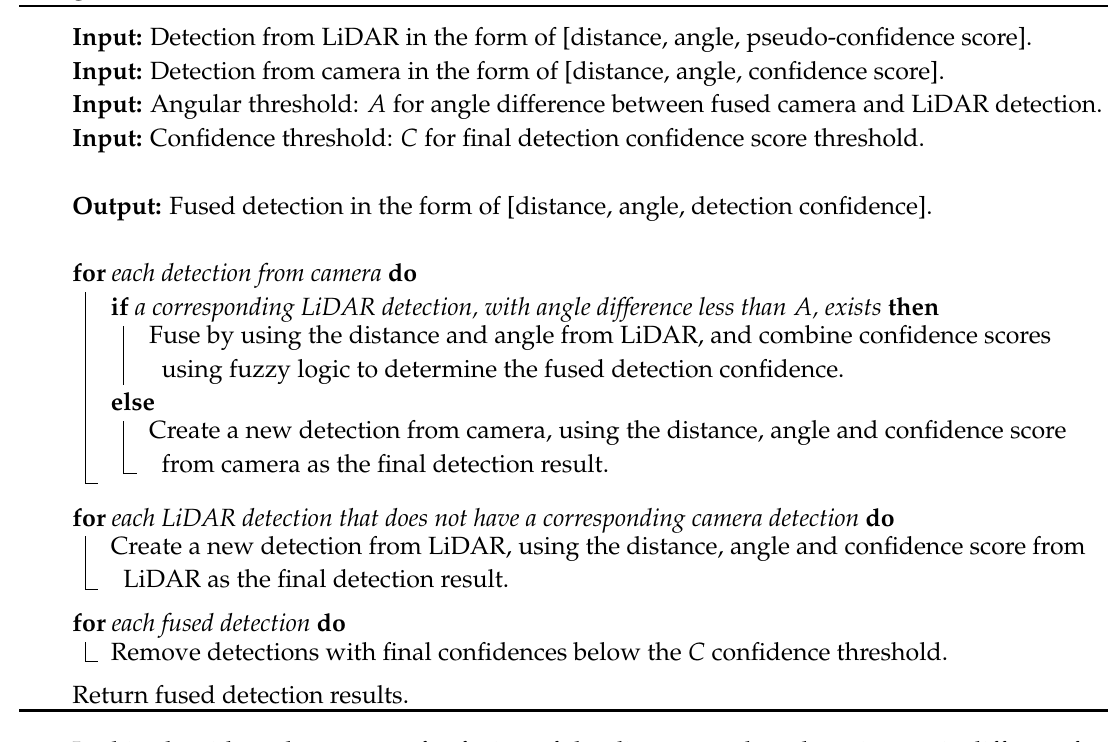
Algorithm 4: Fusion of LiDAR and Camera